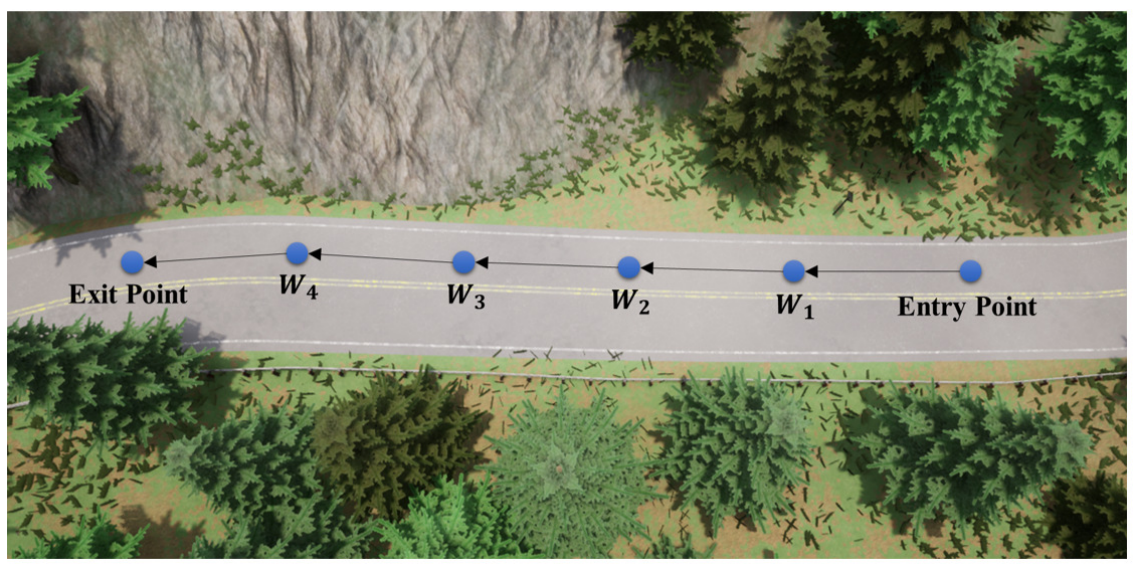
Figure 6. An example of the sequence of waypoints generated via